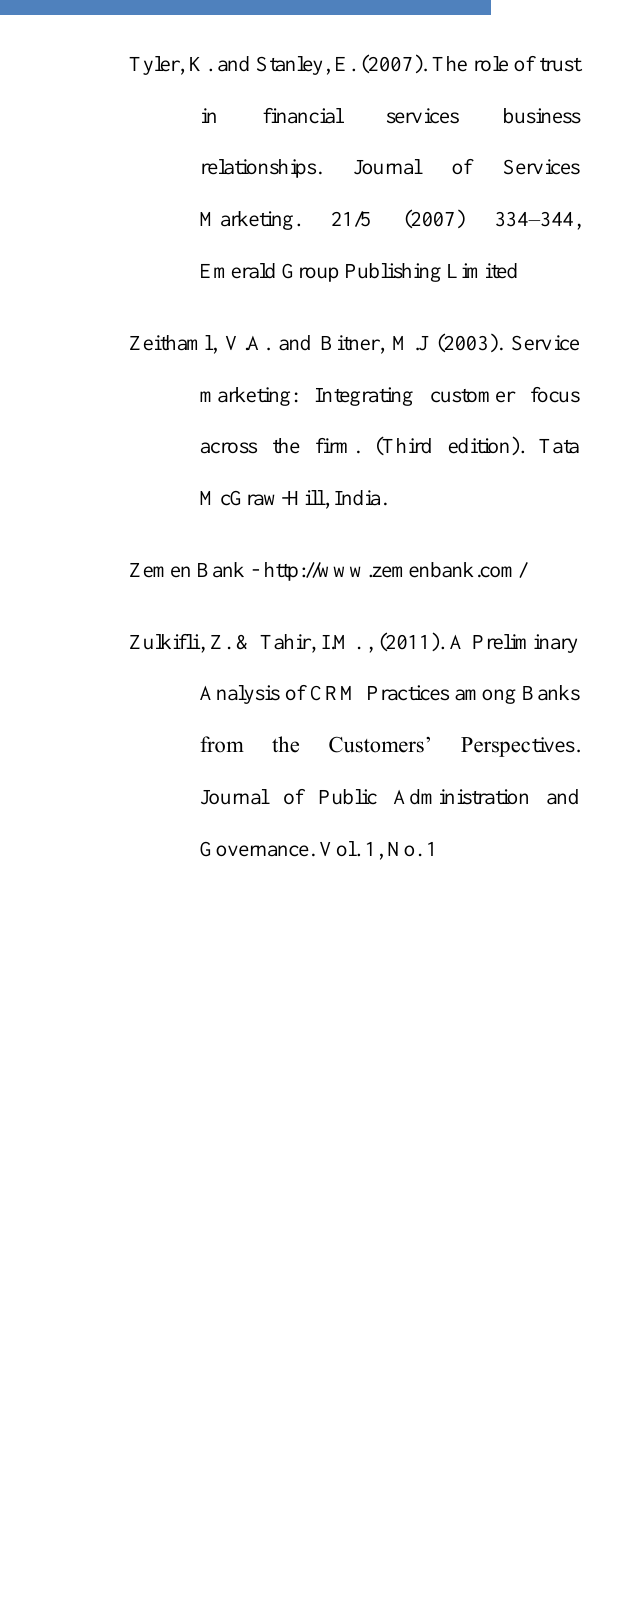
The effect of relationship marketing on customers’ loyalty (Evidence from Zemen